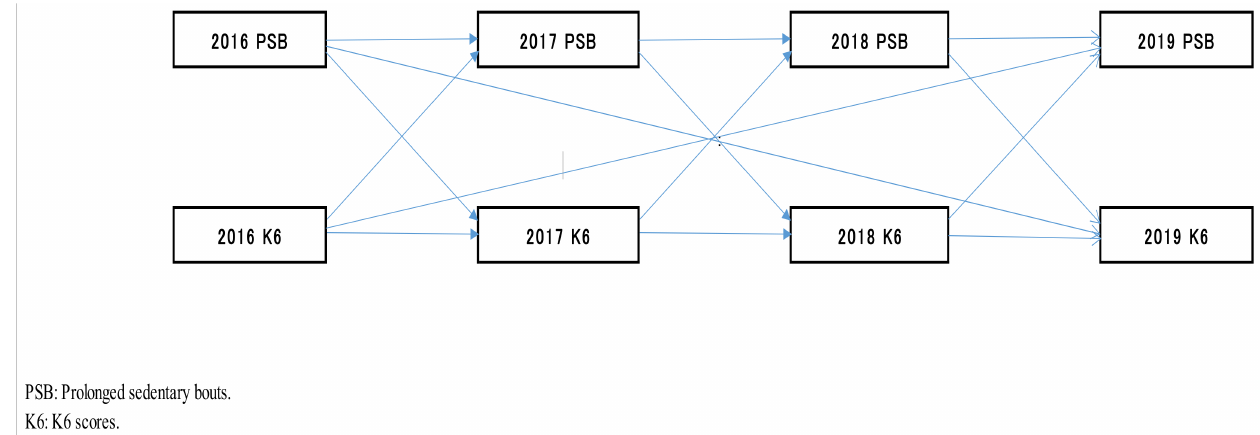
Figure 2. Cross-lagged effects